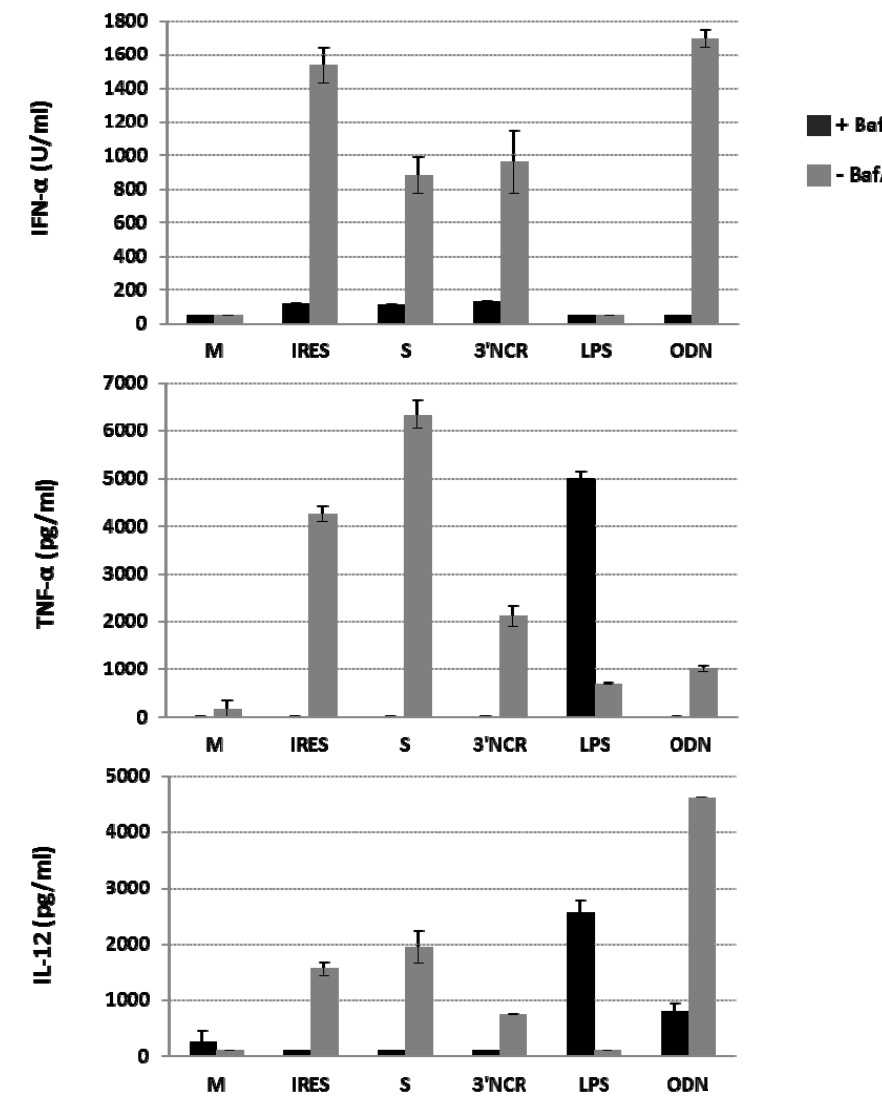
Figure 6. Effect of BafA1 treatment on cytokine induction in ncRNA-transfected PBMCs.